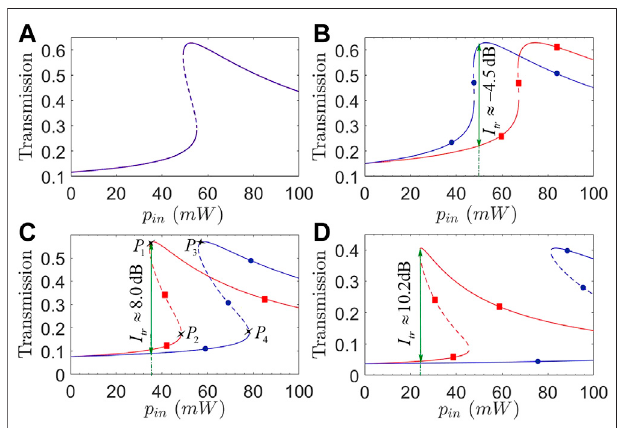
FIGURE 2 | (Color online) Transmission coef fi cients T 31 (red squares) and T 13 (blue circles) against input power p in with (A) J 23 /2 π (cid:1) 1.725 GHz; (B) J 23 /2 π (cid:1) 2.0 GHz; (C) J 23 /2 π (cid:1) 1.4 GHz; (D) J 23 /2 π (cid:1) 1.0 GHz. Solid and dashed parts of each curve refer to stable and unstable regions, respectively. Other parameters are Δ 1 /2 π (cid:1) Δ 2 /2 π (cid:1) 4.5 GHz, Δ 3 /2 π (cid:1) 1.5 GHz, g /2 π (cid:1) 0.9 MHz, ω m /2 π (cid:1) 10 GHz, and J 12 /2 π (cid:1) 3.0 GHz, except those at the beginning of Section 3